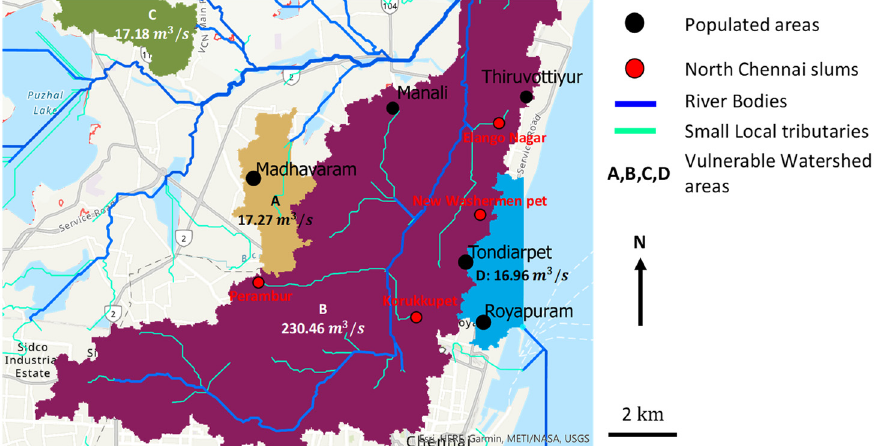
Figure 9. Drainage map of the study region generated from GIS showing major river streams, tanks and vulnerable watershed areas in the North Chennai slum region (Madhavaram, Manali, Thiruvottiyur, Tondiarpet and Royapuram). Region-wise run-off rates are indicated in each watershed area (see number indicated below regions marked A, B, C and